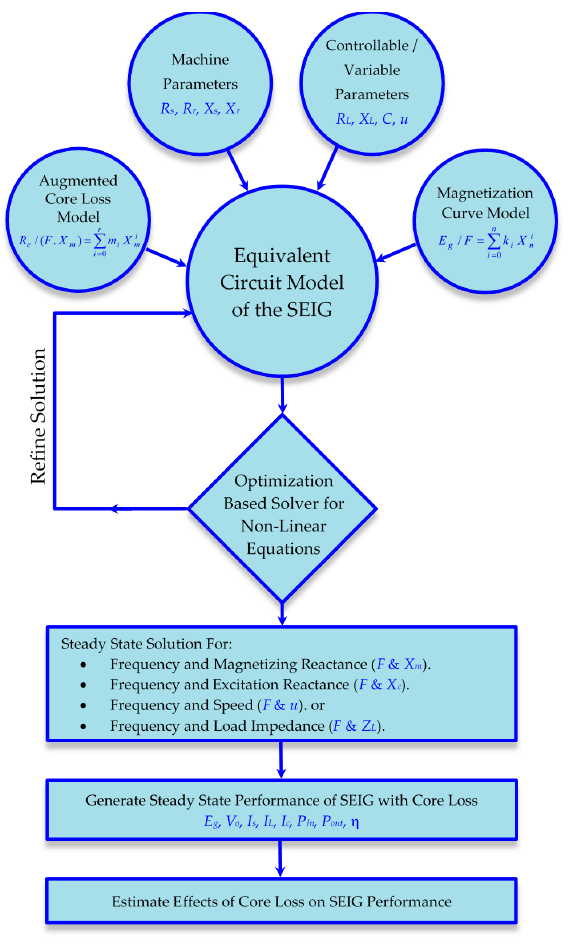
Figure 5. Block diagram of the developed model.